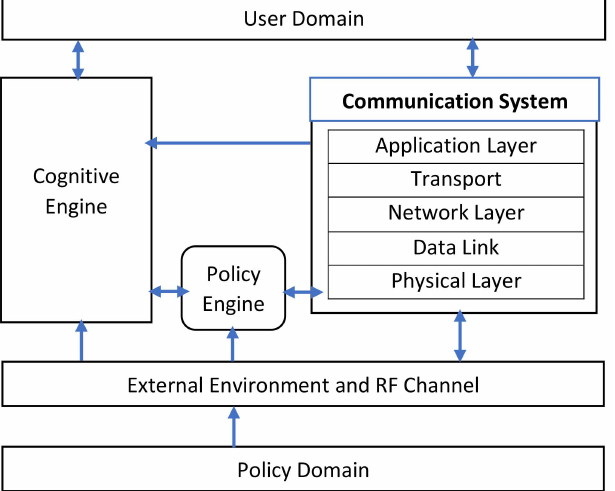
Figure 2. Cognitive radio network architecture.